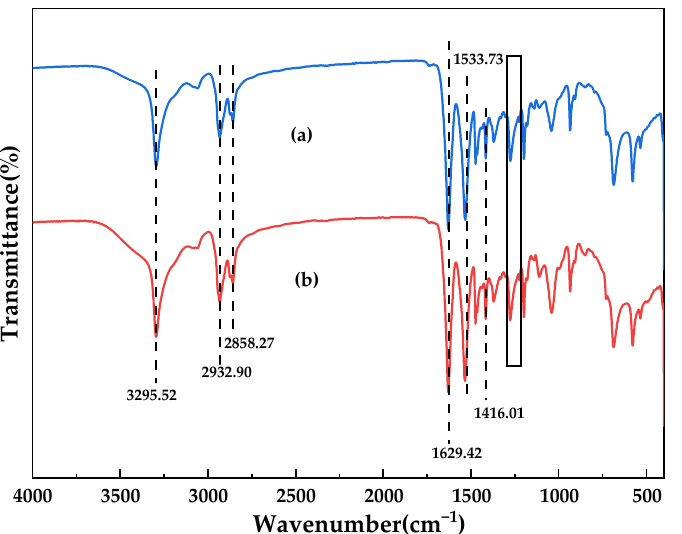
Figure 8. FTIR spectra of PA66 membrane before and after modification by GO. (( a ) P0 membrane; ( b ) P3 membrane).